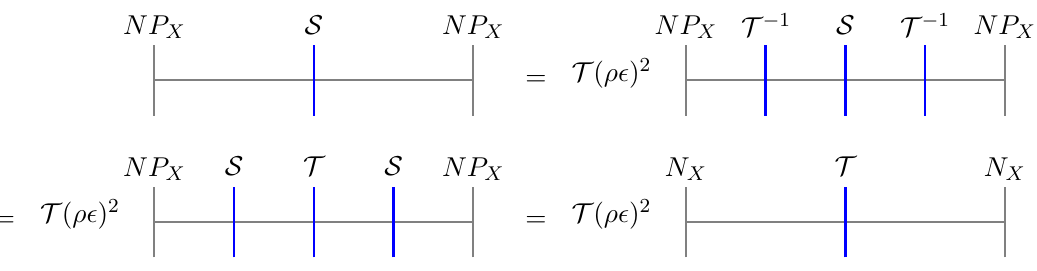
(cid:0) (cid:1) S 3 T